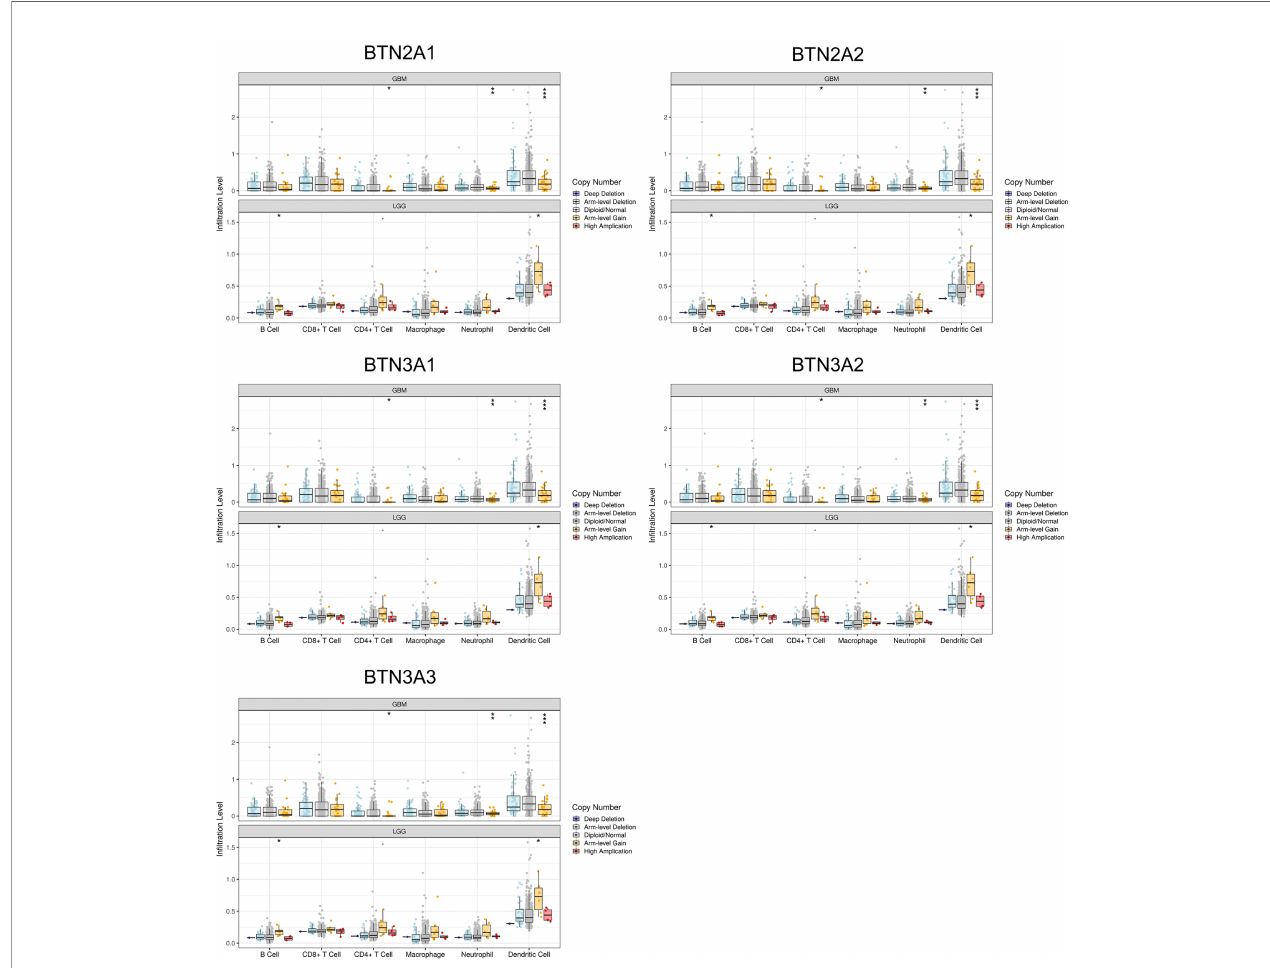
FIGURE 8 | Correlation of tumor-in fi ltrating levels in GBM/LGG and different somatic copy number alterations in the BTN2/3 subfamily members. The arm-level deletion of BTN2/3 subfamily members was signi fi cantly associated with immune cell in fi ltration levels in GBM, and the arm-level gain of BTN2/3 subfamily members was signi fi cantly associated with immune cell in fi ltration levels in LGG. GBM, glioblastoma; LGG, low-grade glioma. *P < 0.05; **P < 0.01; ***P <